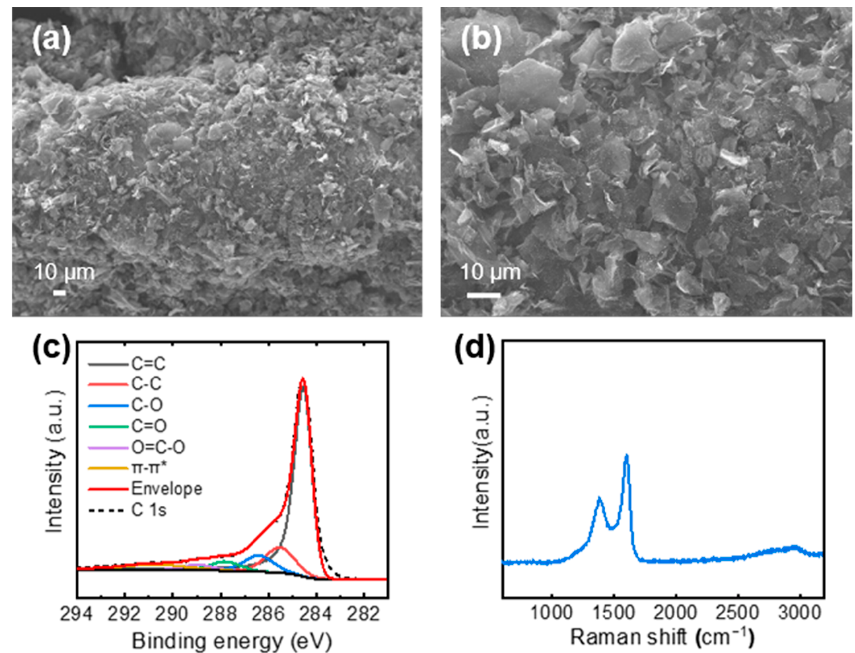
Figure 3. ( a , b ) SEM images of the AG/rGO-coated P-Cu mesh at ( a ) low and ( b ) high magnification. ( c ) XPS C 1s spectra and ( d ) Raman spectrum of AG/rGO.